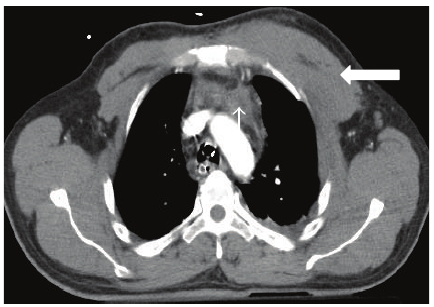
Figure 5: Polytraumatized patient who was hit by a car. Axial MDCT after intravenous contrast administration, at the level of aortic arch, demonstrates mediastinal hemorrhage (thin arrow) and left anterior chest muscle wall hematoma (pectoralis major, thick arrow).